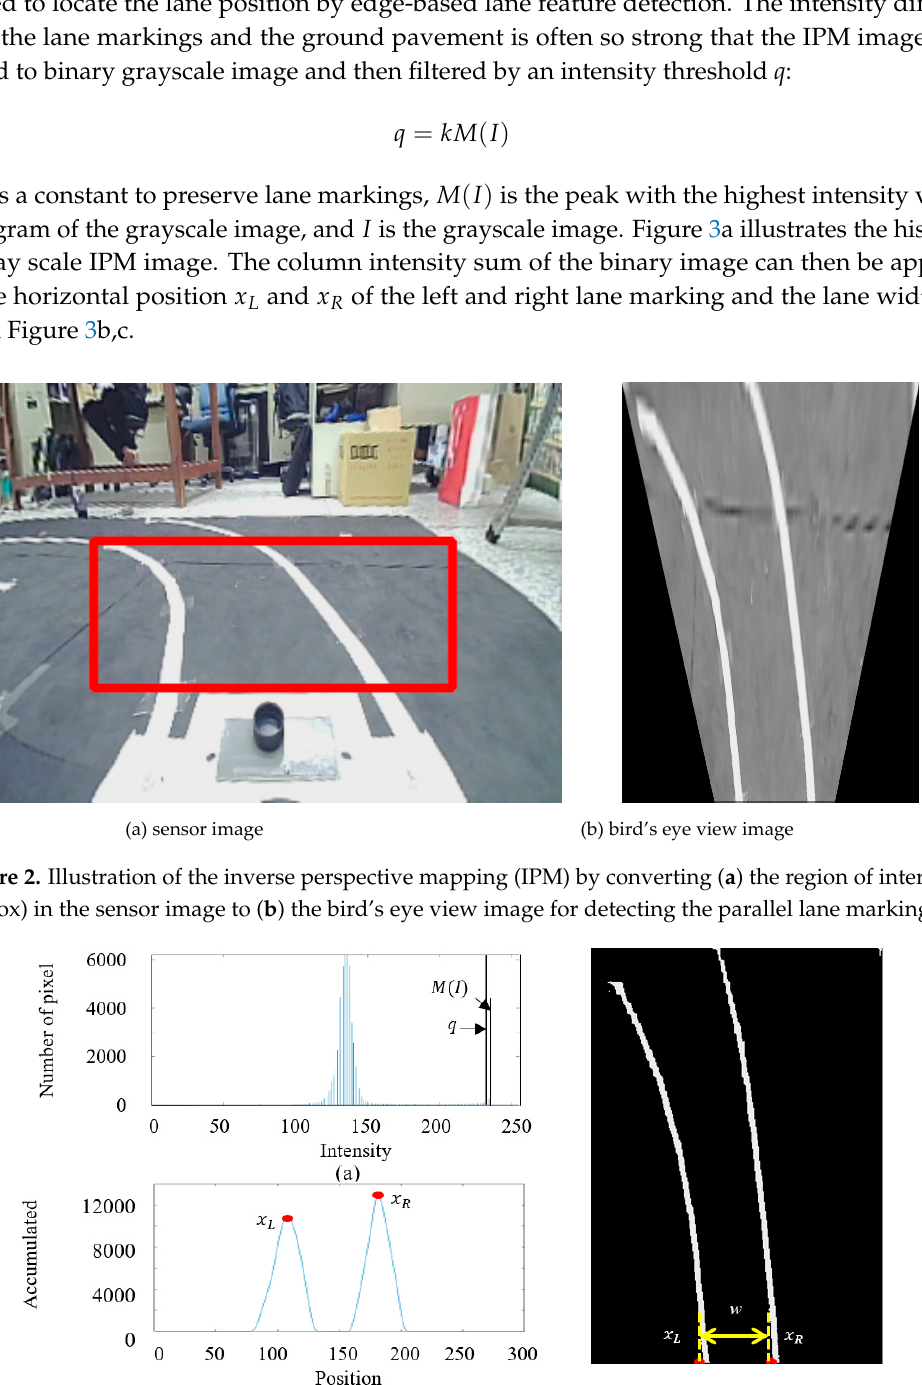
Figure 3. ( a ) Histogram of the grayscale bird’s eye view image with M ( I ) representing the highest intensity value and the intensity threshold q , ( b ) the column intensity sum of the bottom half of the image with peaks at the left and right lane markings, x L and x R , and ( c ) the result of thresholding with lane width w and position of x L and x R